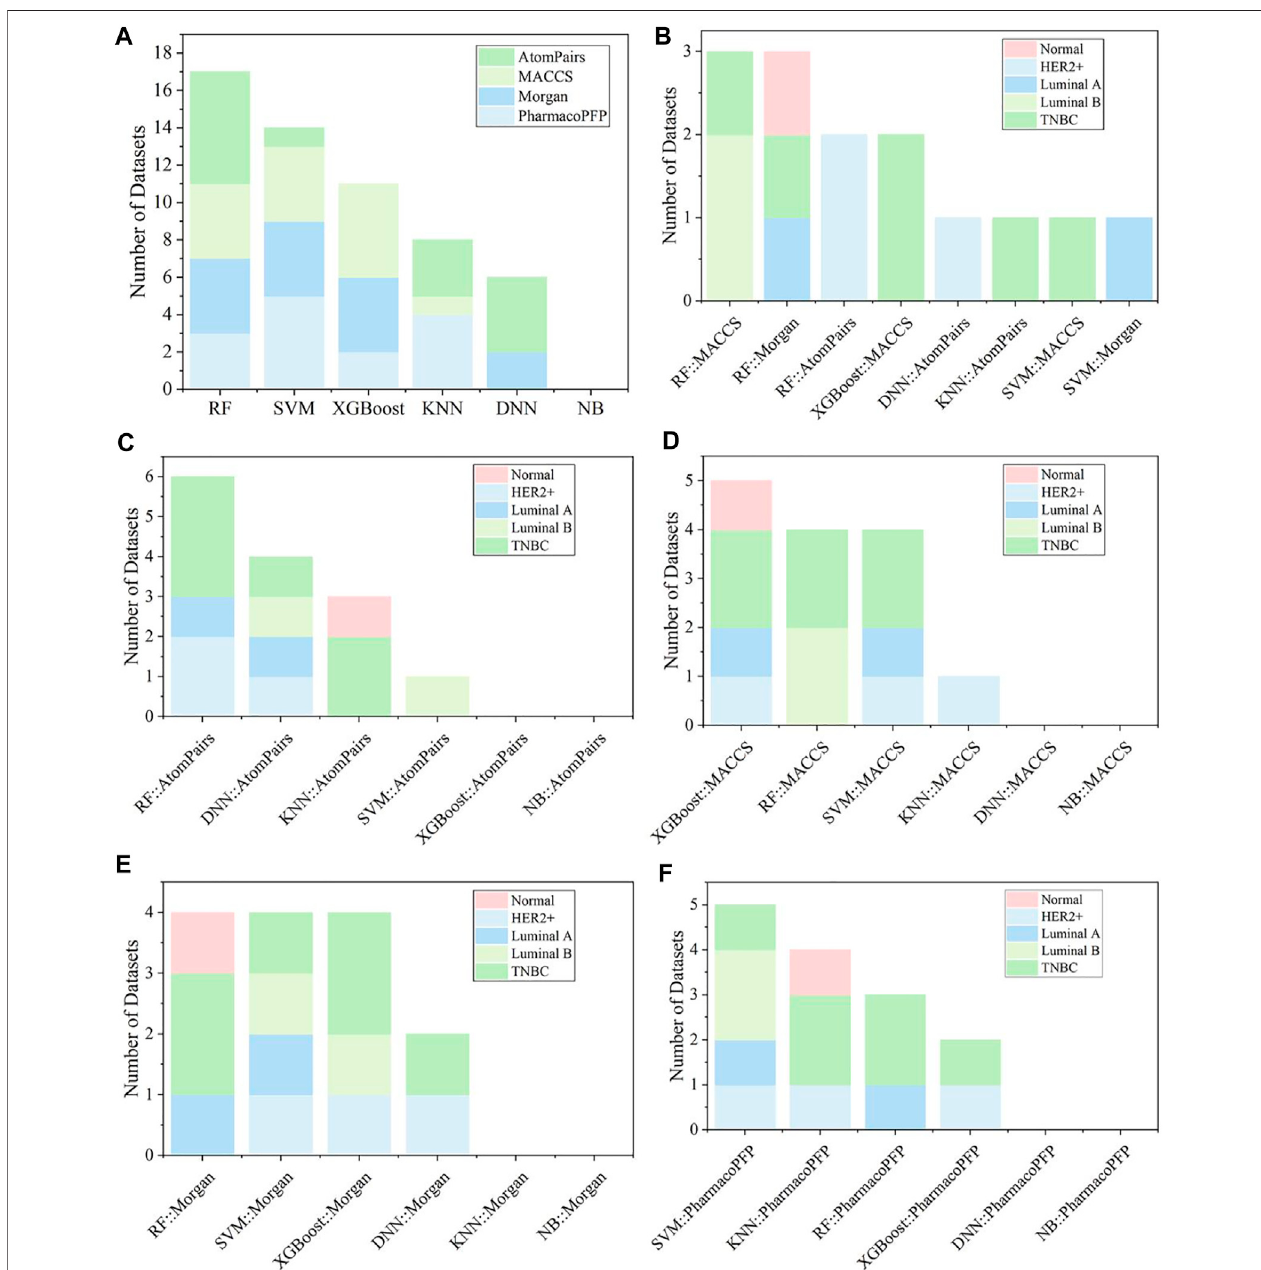
FIGURE5|(A) Summaryoftheoptimalmodelsforeach fi ngerprint-basedfeature. (B) Thebestmodelsamongvarious fi ngerprint-based modelsfordifferentkinds of breast cell lines. The optimal models based on (C) AtomPairs, (D) MACCS, (E) Morgan, and (F) PharmacoPFP for different subtypes of breast cell lines.